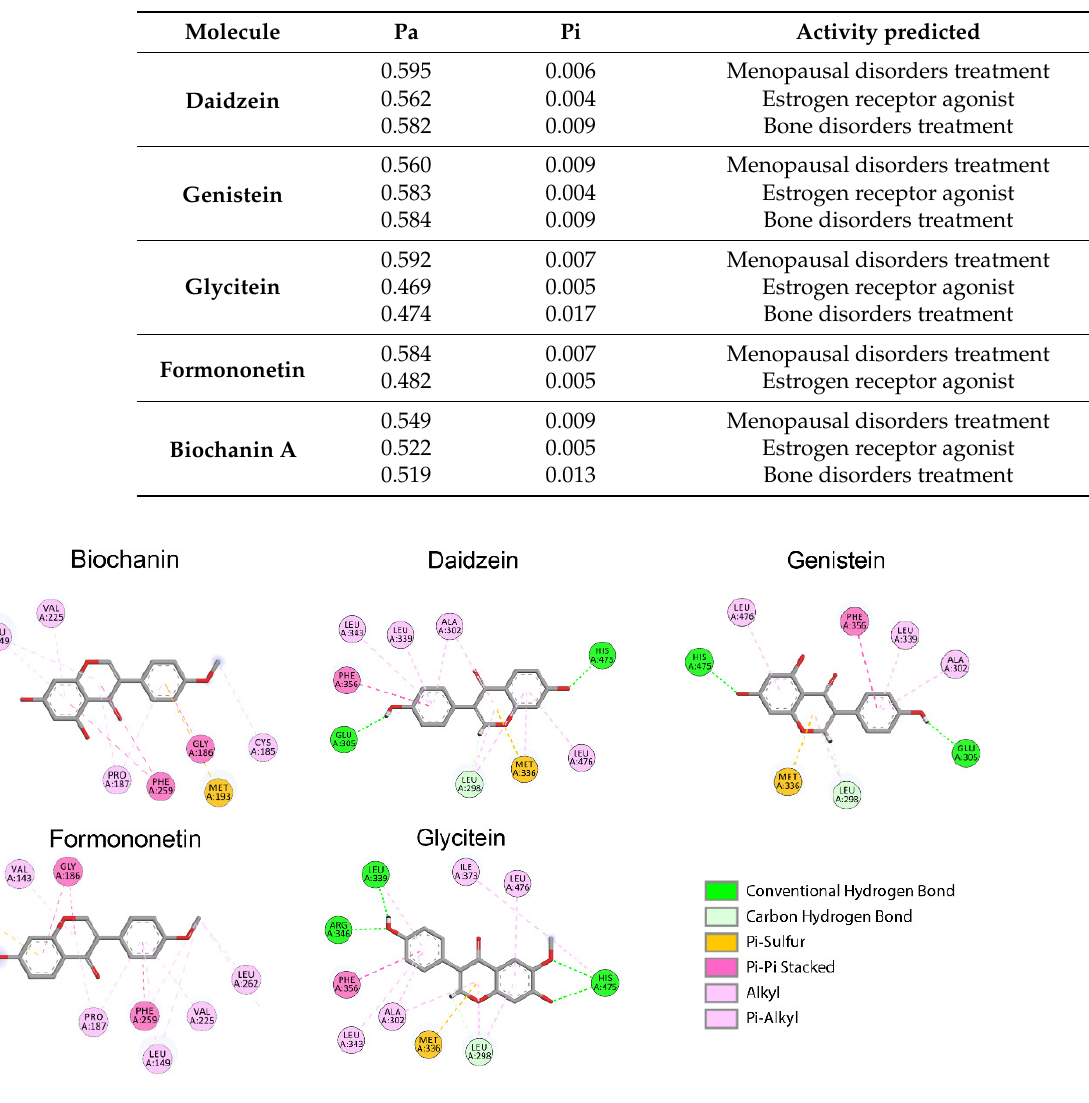
Table 2. Prediction of Activity Spectra for Substances (PASS), where Pa means the probability of activity and Pi means the probability of inactivity.